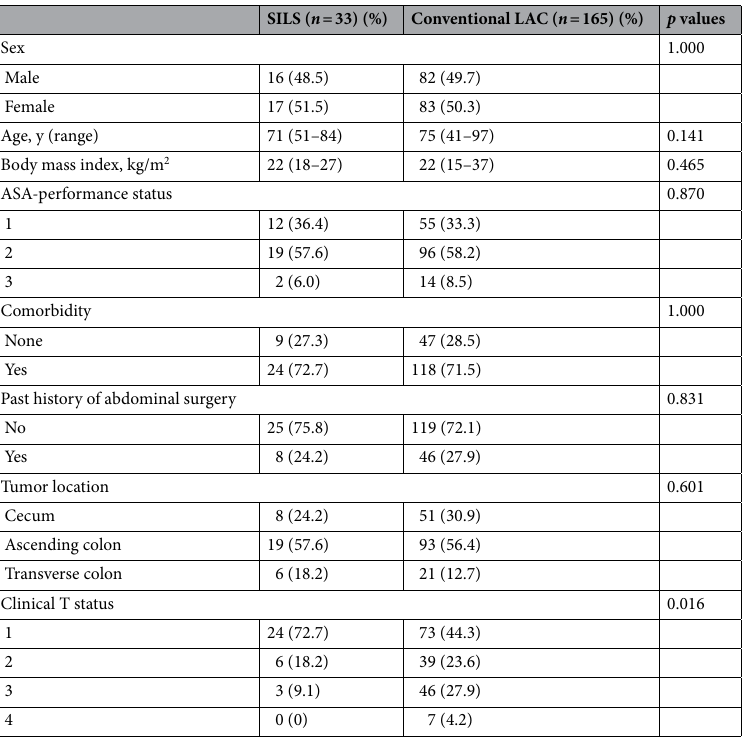
Table 2. Comparison of clinical characteristics between SILS and conventional LAC. Data are presented as numbers of patients or medians (range). ASA American Society of Anesthesiologists, SILS single-incision laparoscopic surgery, LAC laparoscopic surgery. Differences in categorical variables were compared using Fisher’s exact test or the chi-squared test, as appropriate. Differences in continuous variables were analyzed with the Mann–Whitney U